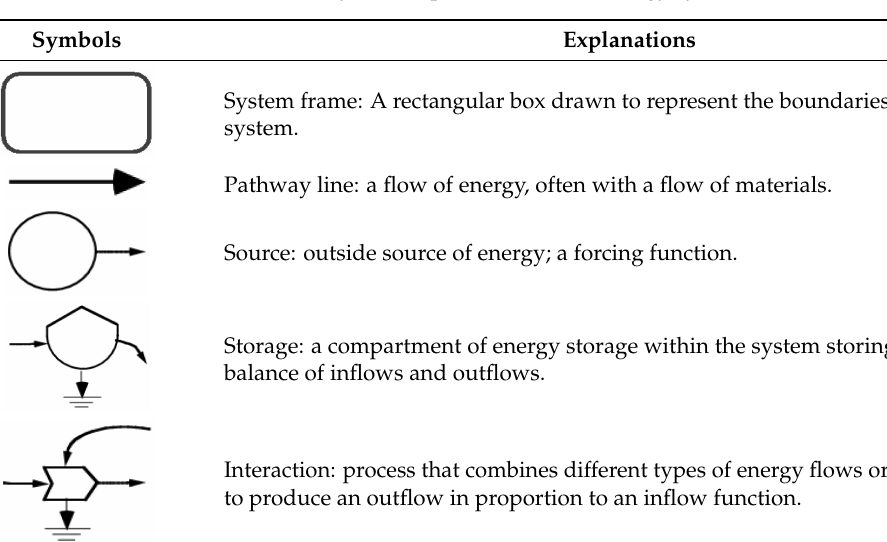
Table 1. Symbol explanations of an emergy